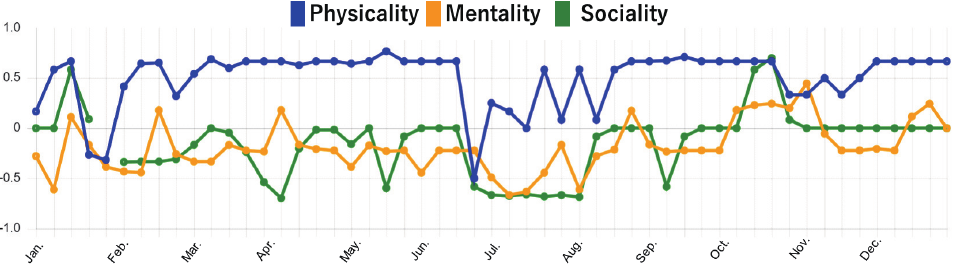
Figure 7. Self − evaluation results of subject D in the period of this